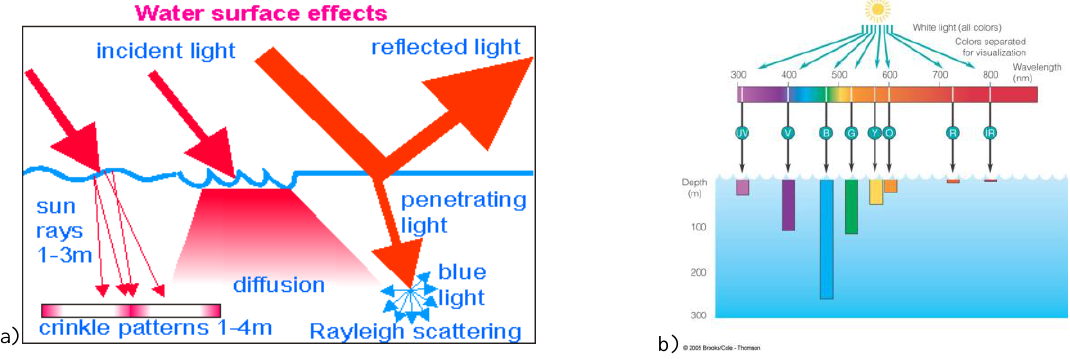
Figure 2. (a) Water surface effects on incident sunlight (Floor, 2005); (b) selective light absorption of colour (wavelength) in the open ocean (Kennesaw State University).